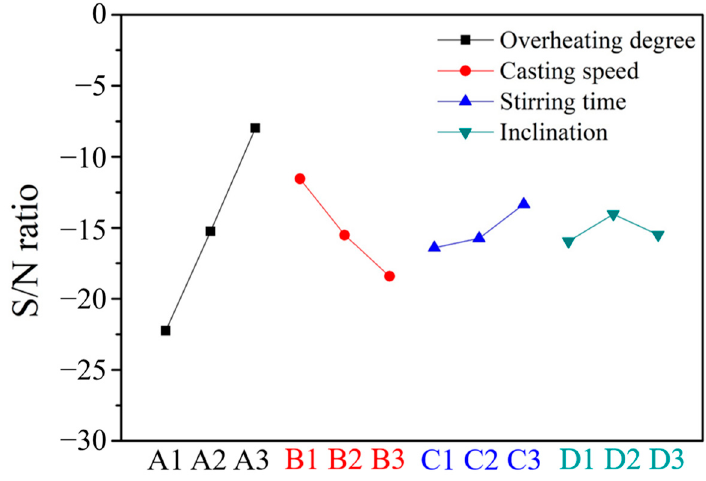
Figure 7. Main effect plot of the S/N ratios at various clog thicknesses.